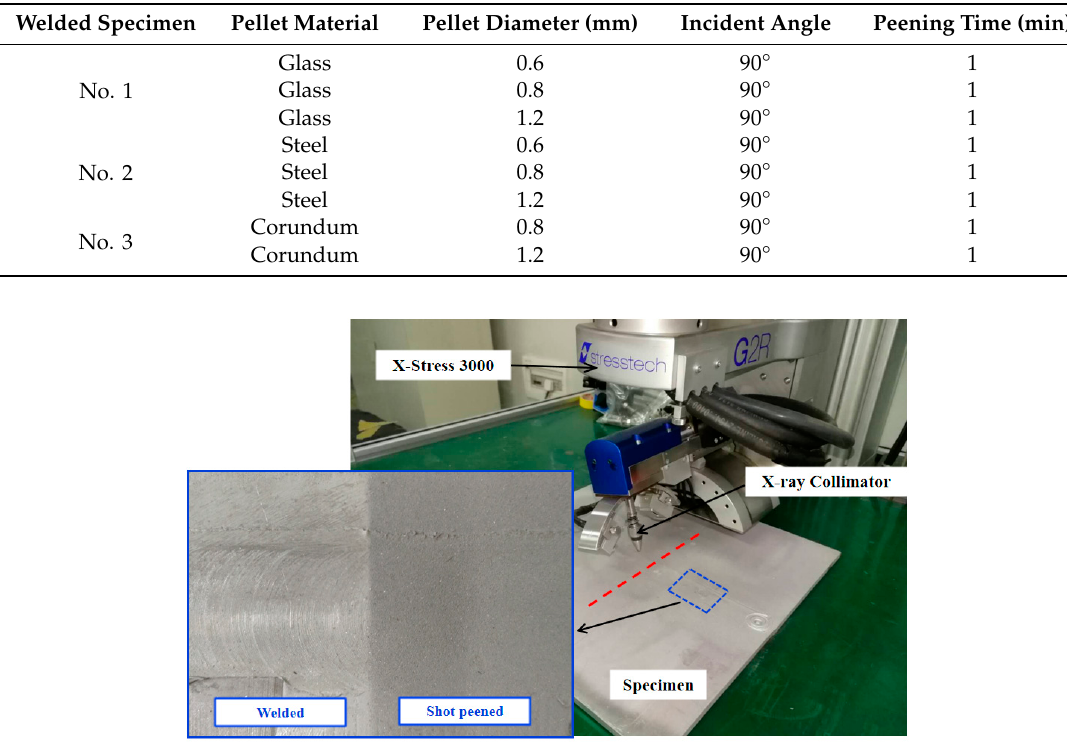
Figure 2. The process of measuring residual stress by XRD.